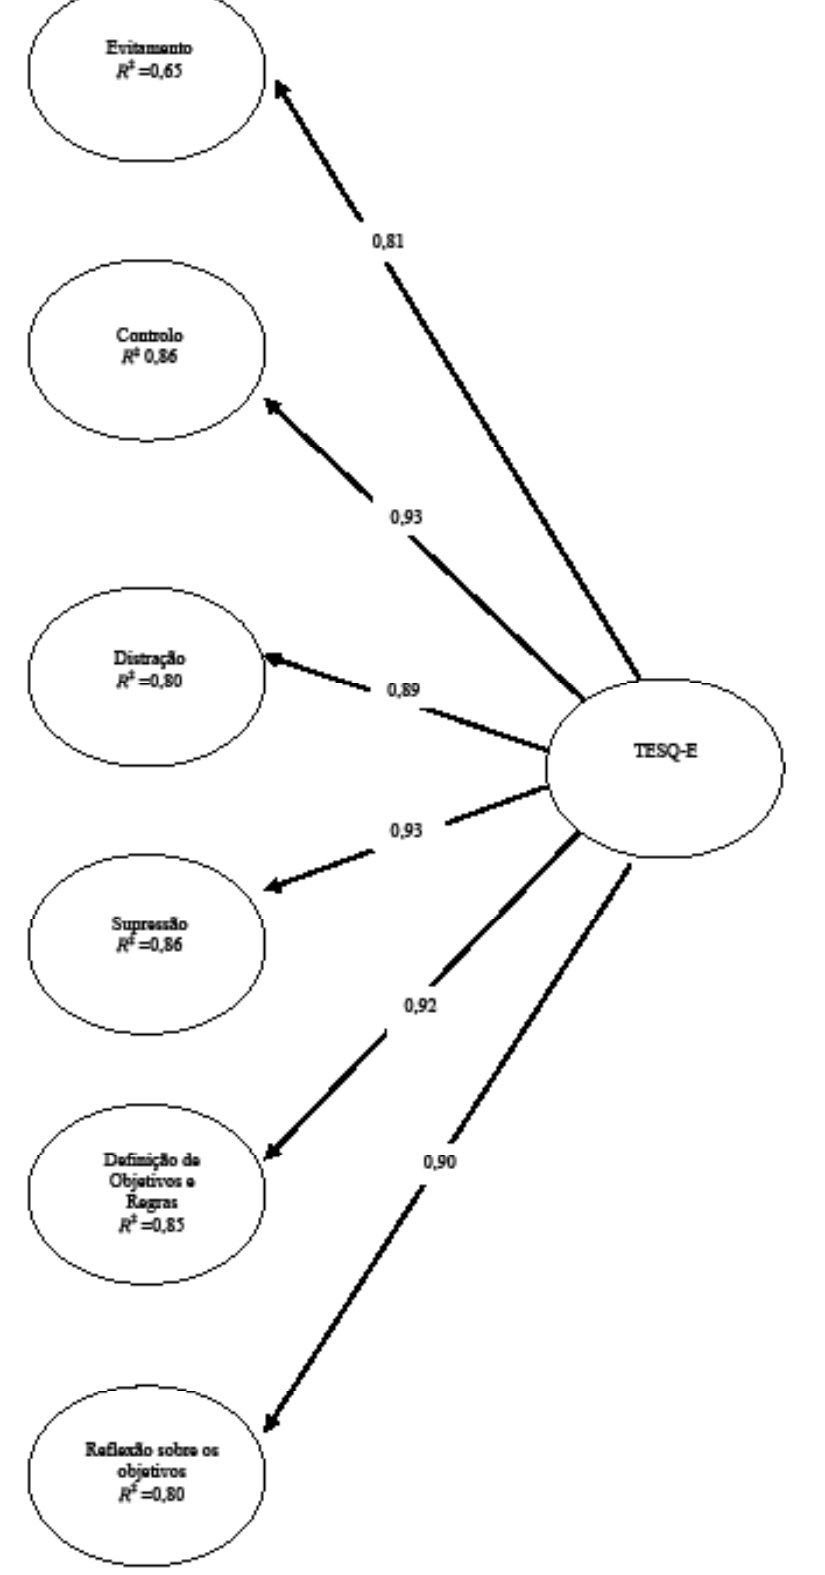
Figura 1 . Análise fatorial con fi rmatória